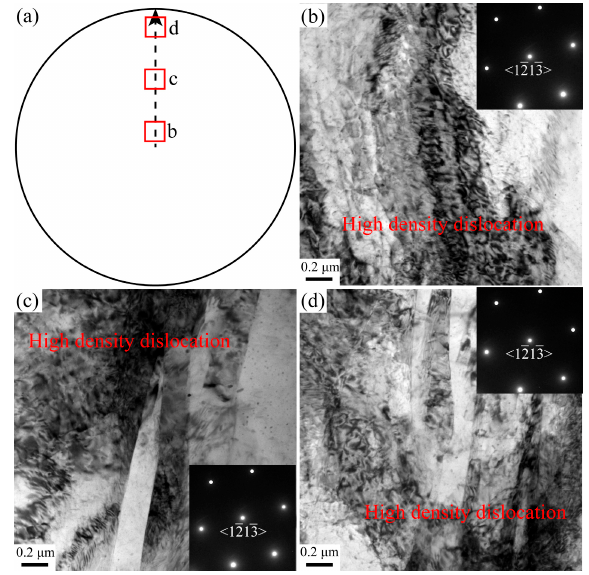
< > < > direction: ( a ) direction: ( a )